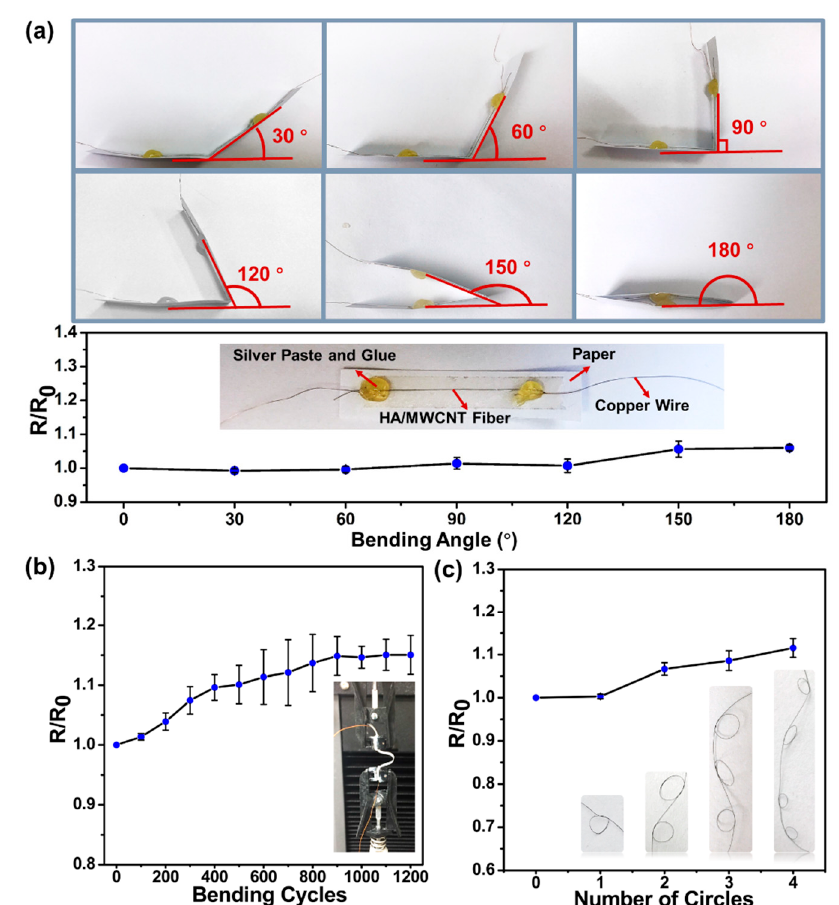
Figure 8. The stability properties of the HA/MWCNT hybrid microfibers. ( a ) Effects of bending angles on the resistance of HA/MWCNT microfibers on a paper substrate; inset: A graphic illustration of the test method for the HA/MWCNT microfibers; ( b ) The resistance stability results of the HA/MWCNT microfibers over 1200 folding-unfolding cycles; inset: A photograph showing the fiber being operated on by the tensile machine; and ( c ) The dependence of resistance on different numbers of tied circles.